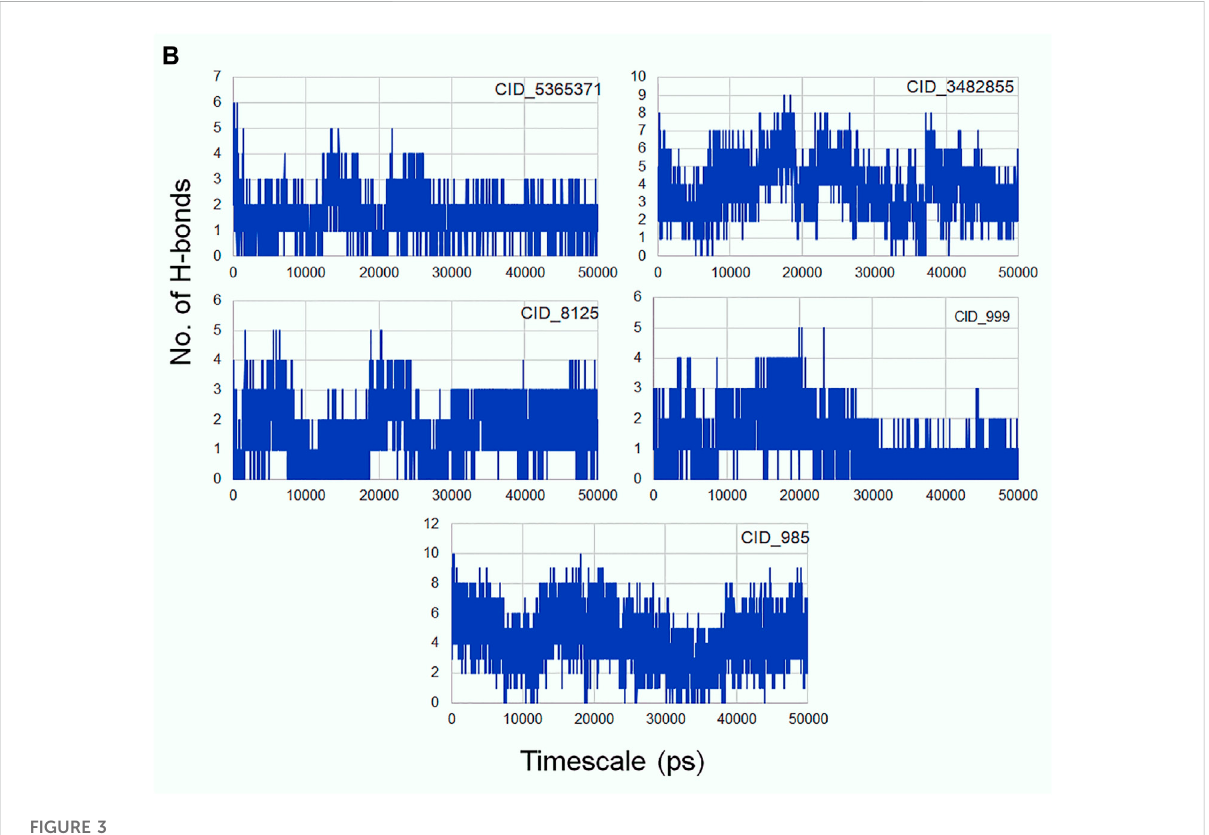
FIGURE 3 (A) Molecular dynamics simulation of CDC42 with ligands ( β -sitosterol, phenylacetic acid, palmitic acid, behenic acid, and erucamide); (B) H-bond interaction of CDC42 and ligand